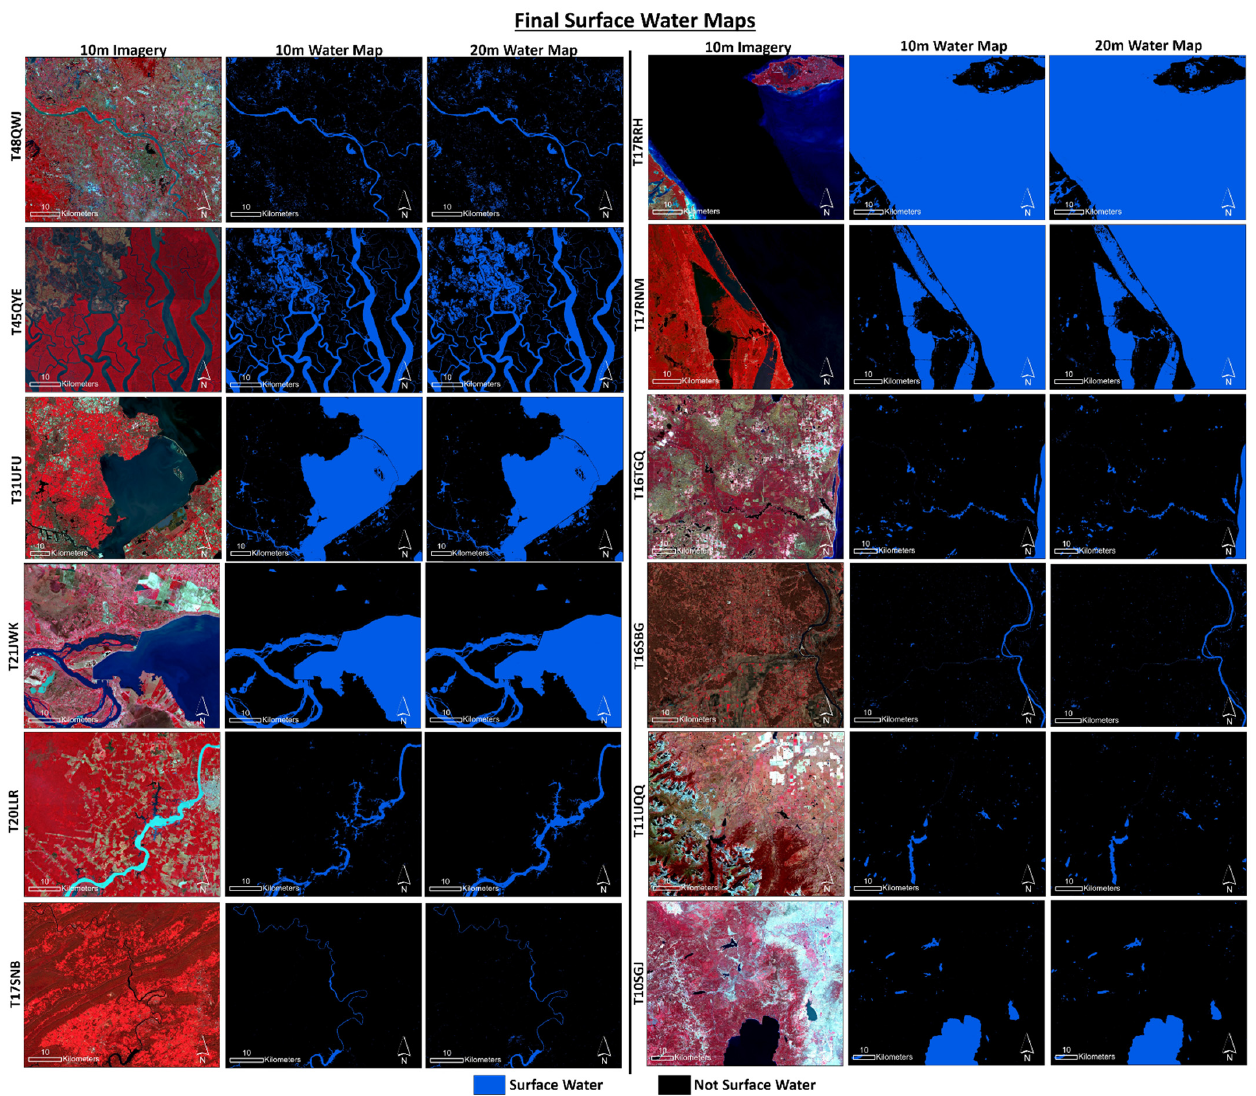
Figure 6. Comparison of the final 10 m and 20 m surface water maps across the 12 international test sites shown with the 10 m Sentinel-2 imagery in false color composite. The Sentinel-2 granule identifier is listed on the left side of the imagery. Table 2. Comparison of the 10 m and 20 m surface water maps showed an average 4.3% difference in area.